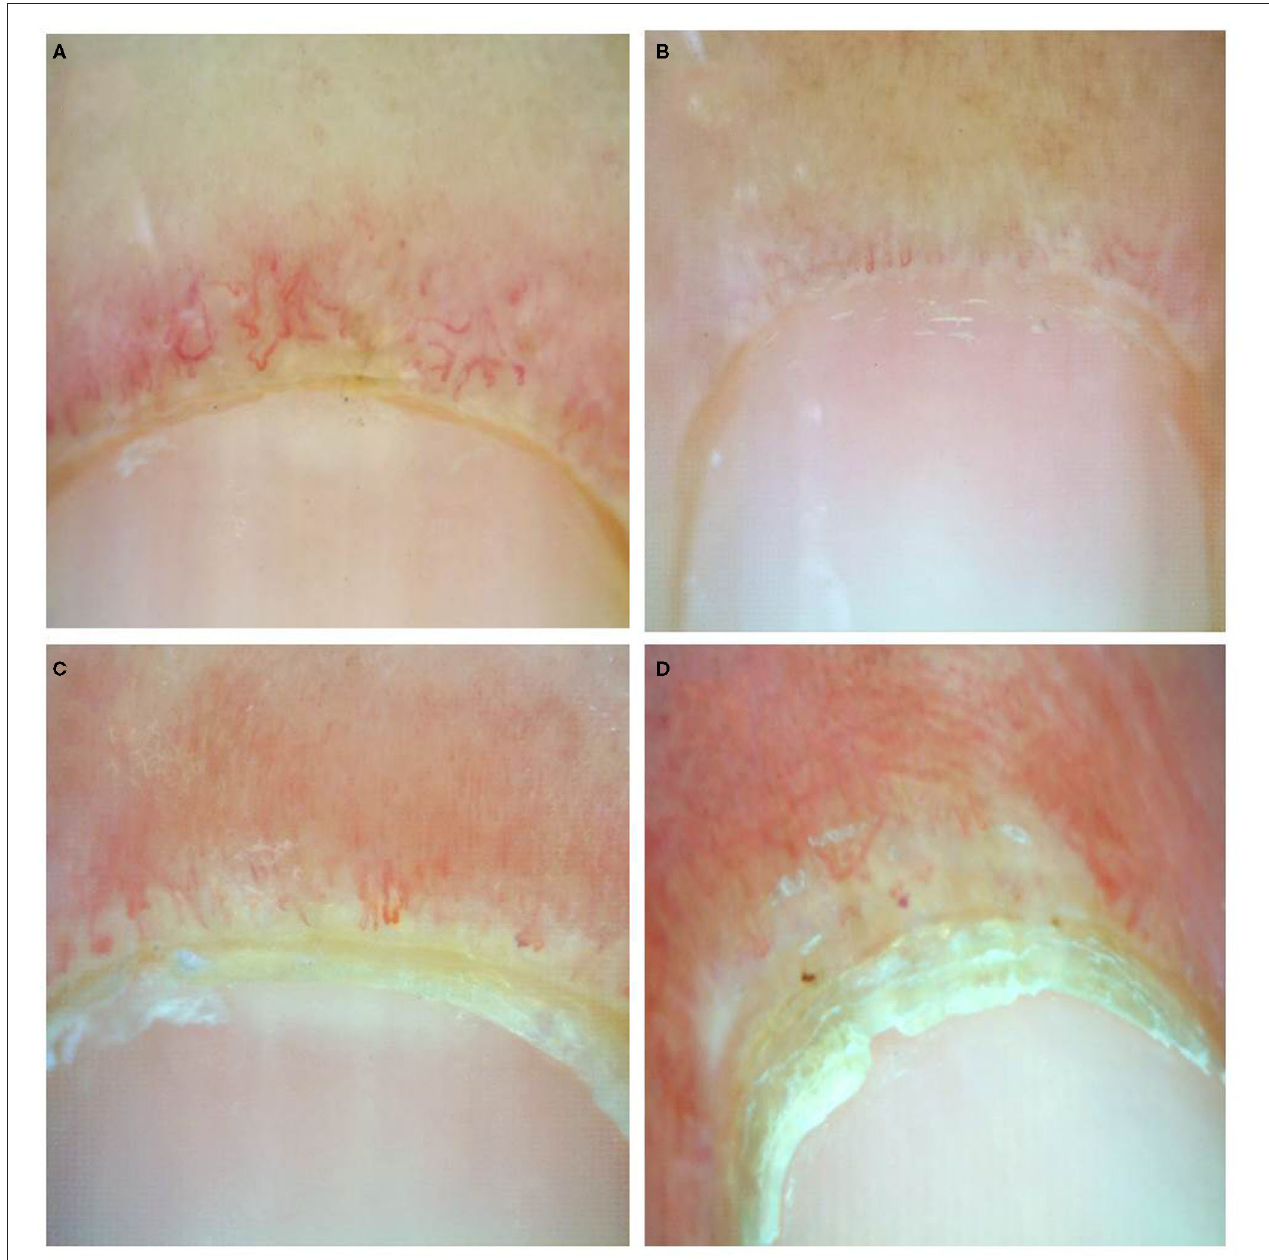
FIGURE 3 | Onychoscopic architectural features: (A) disorganized capillaries, (B) avascular area grade 1, (C) grade 2, and (D) grade 3.